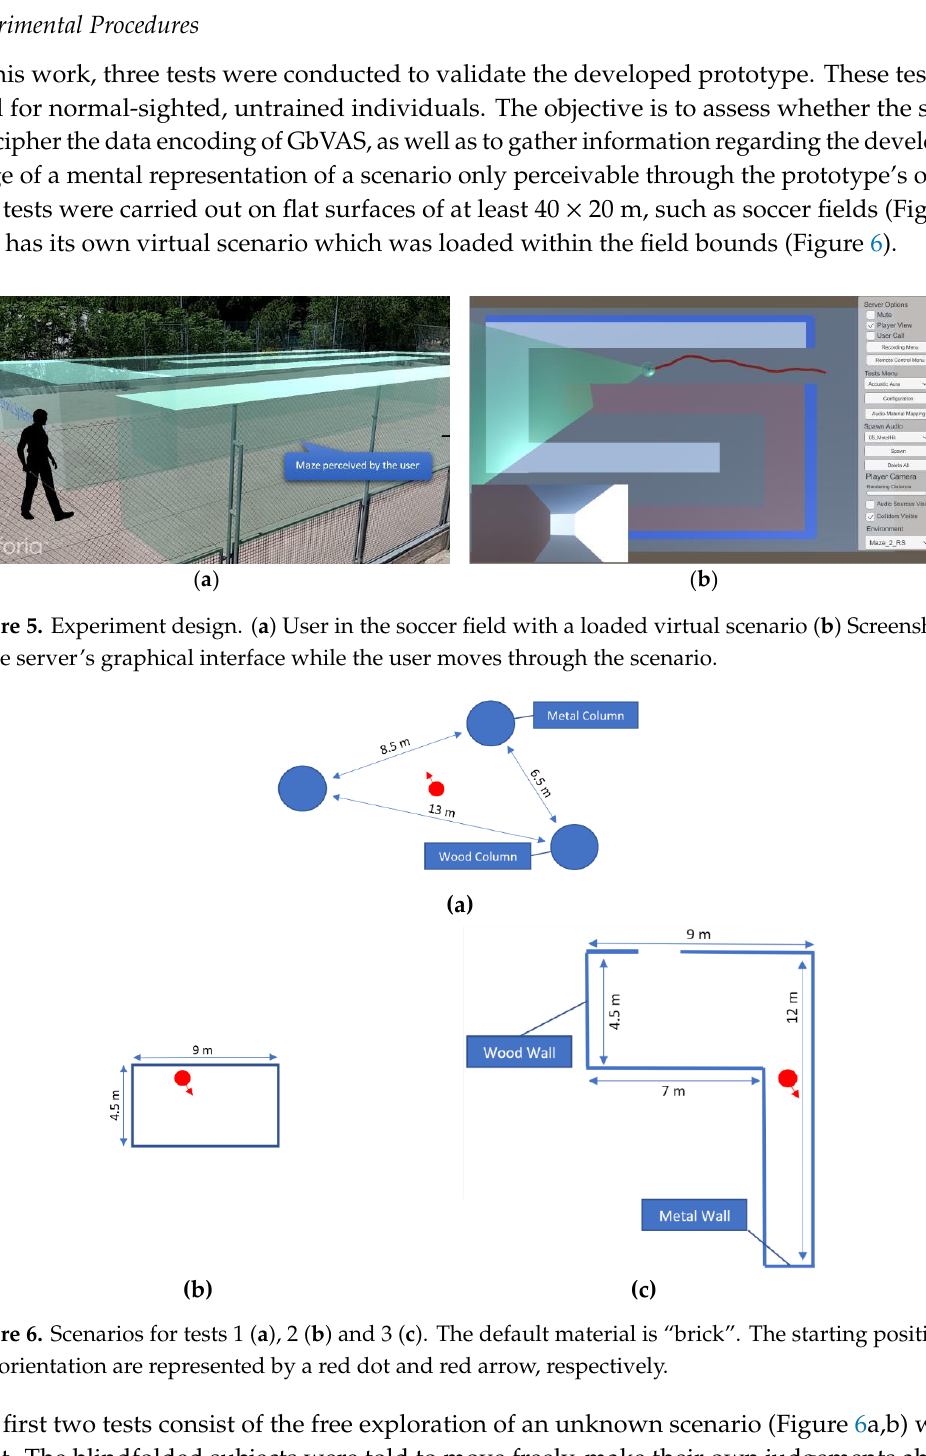
Figure 5. Experiment design. ( a ) User in the soccer field with a loaded virtual scenario ( b ) Screenshot of the server’s graphical interface while the user moves through the scenario.